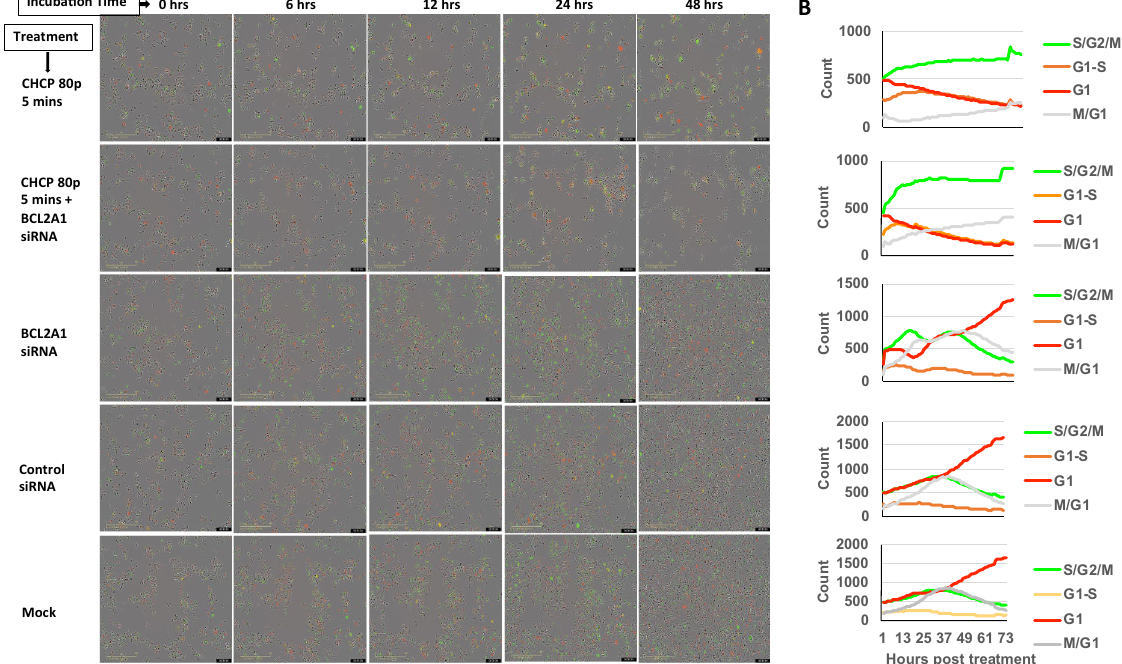
Figure 8. Silencing of BCL2A1 expression increases cell death at G1 phase of the cell cycle after CHCP treatment. ( A ) Representative pictures of IncuCyte live cell image showing the live state of MDA-MB-231-Cell Cycle Green/Red reagent stable cells treated with/without CHCP treatment or siRNA BCL2A1. The CHCP treated cells recover 50% of the time but when transfected with siRNA-BCL2A1 in combination with CHCP, such recovery is inhibited. ( B ) Shows the line graph for the quantification of the cells in G1, G1-S, S/G2/M, and M-G1 phases after CHCP treatment corresponding to section